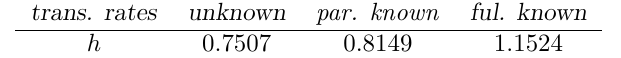
Table 2: The maximum stable delay of the MJNNS with transition rates unknown, partly known and fully known trans. rates